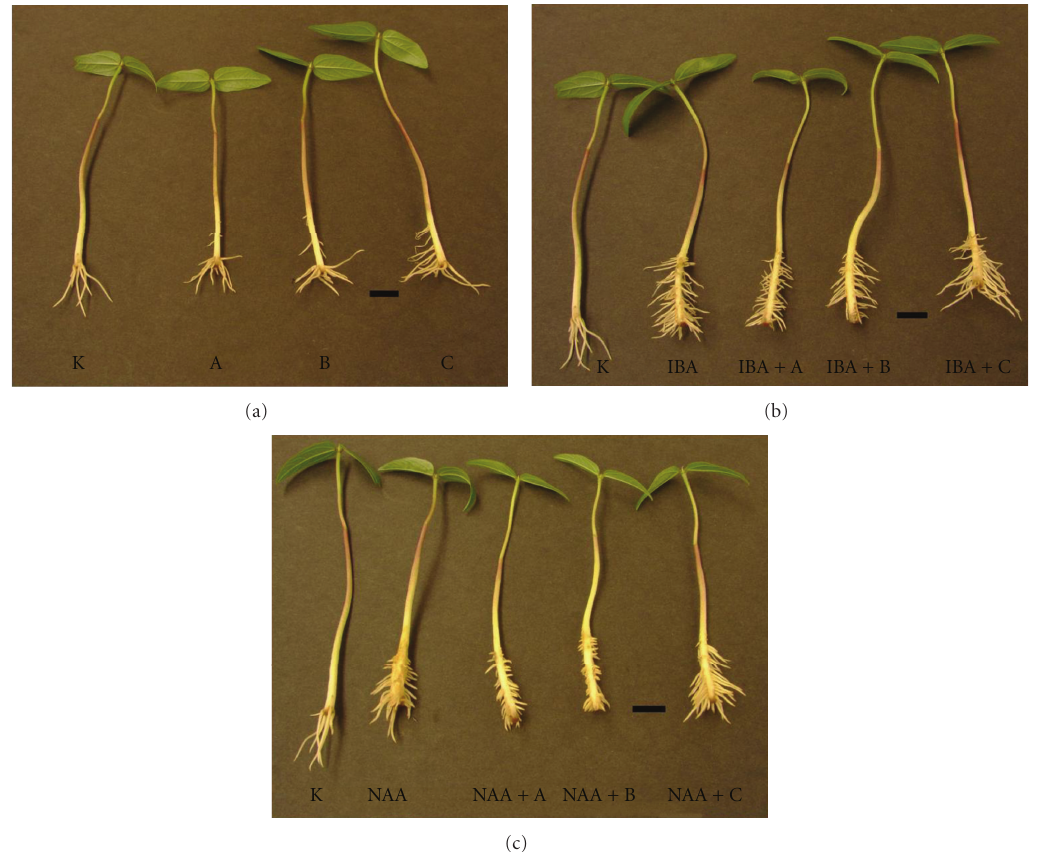
Figure 2: E ff ect of GGMOs, GGMOs-r, and GGMOs-g alone, and in combination with IBA or NAA on the rooting and adventitious root elongation of mung bean hypocotyl cuttings. K: control, without any plant growth regulators, A: GGMOs, B: GGMOs-r, C: GGMOs-g, bar =